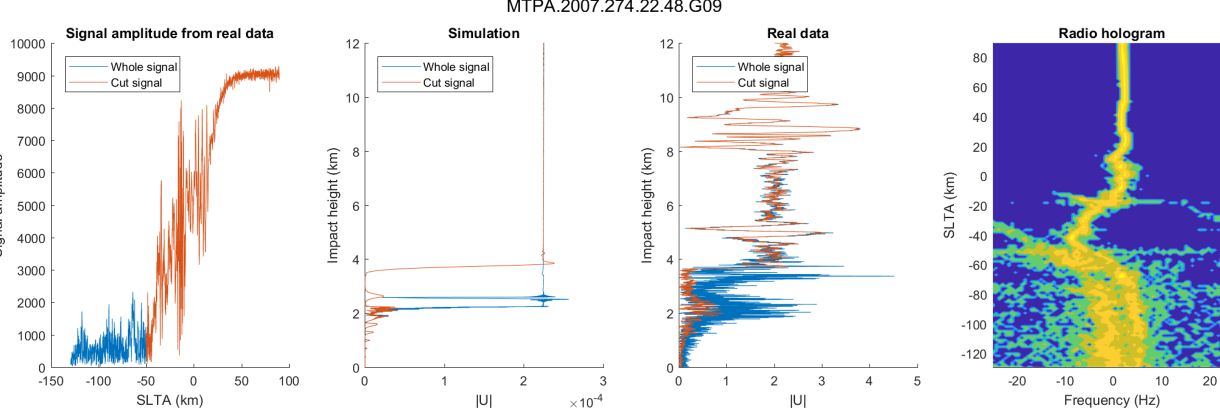
Figure 12. An event classified as category 4. SLTA min is at approximately − 103km, and the signal is truncated at SLTA = − 50km. The reflection spike is located at an impact height of 1994m, and a min is